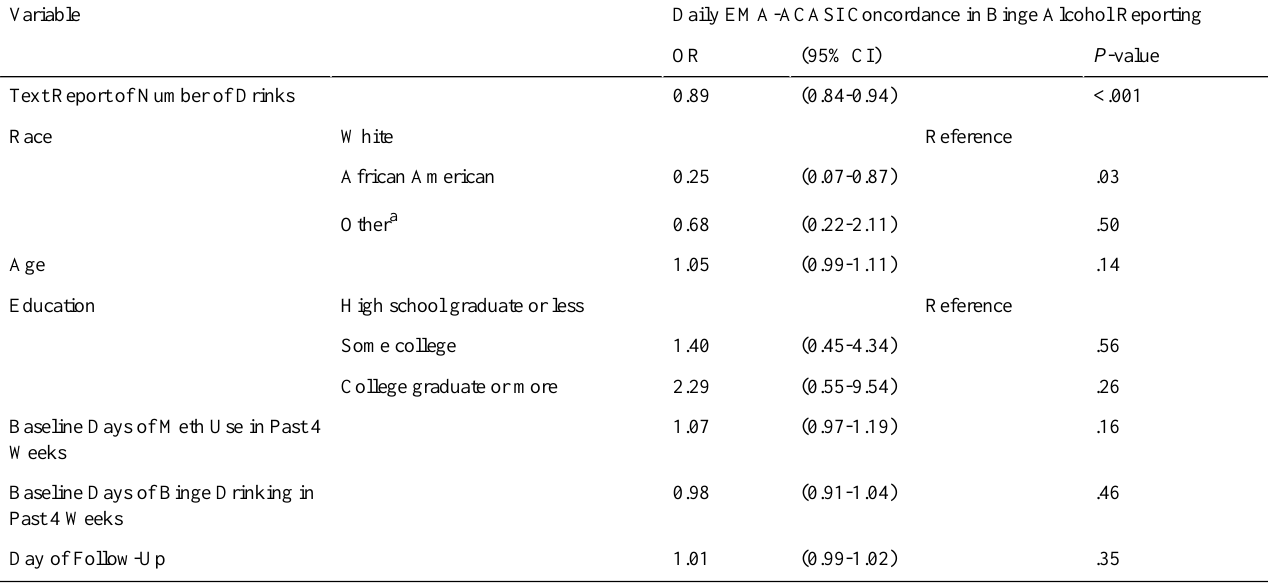
Table 6. Multivariable logistic regression model, fit with generalized estimating equations, assessing daily EMA-ACASI concordance in binge alcohol reporting (with text report of number of drinks predictor)